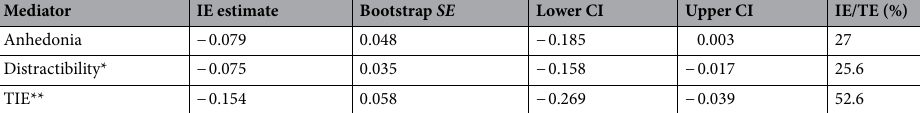
Table 5. Results from the single-step multiple mediator model. CI confidence interval, IE indirect effect, TE total effect, TIE total indirect effect. * p < 0.05; ** p < 0.01.